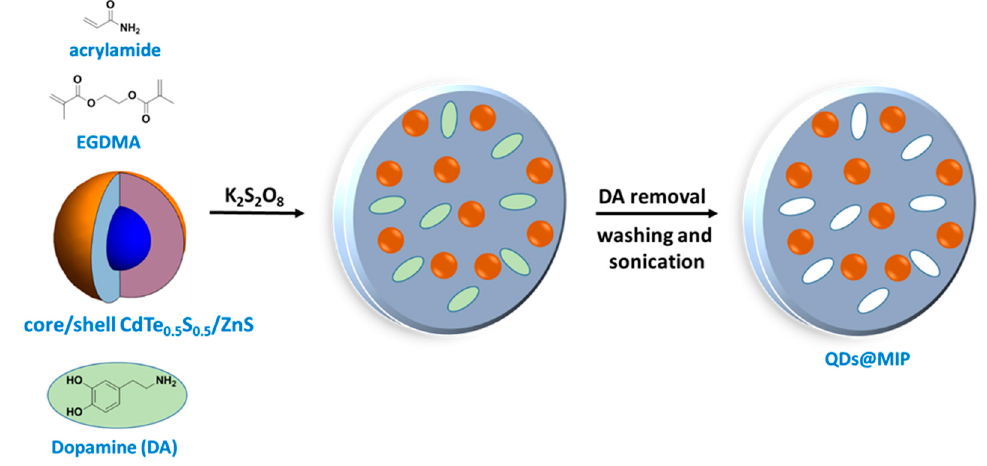
Scheme 1. Schematic illustration of the preparation of molecularly imprinted polymer-modified